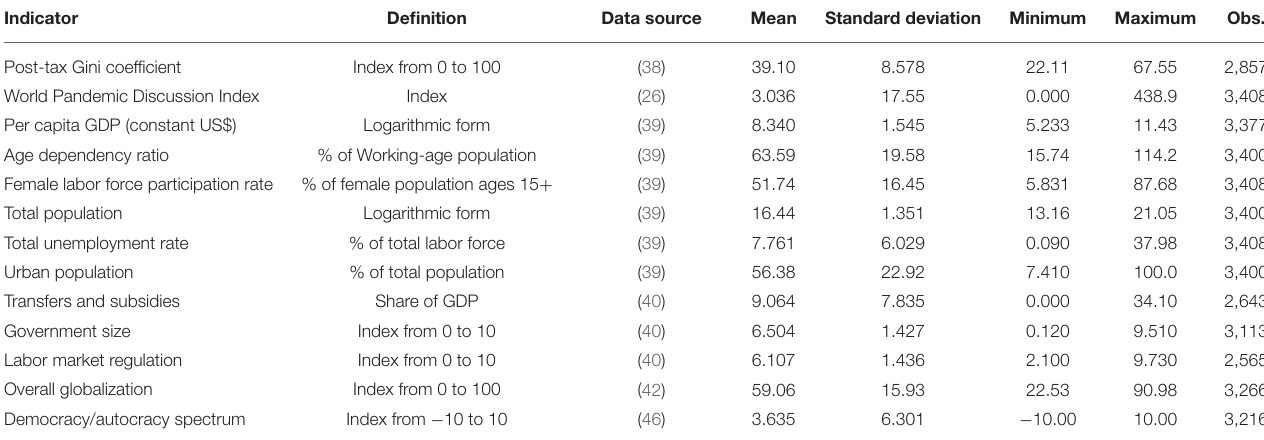
TABLE 1 | Descriptive